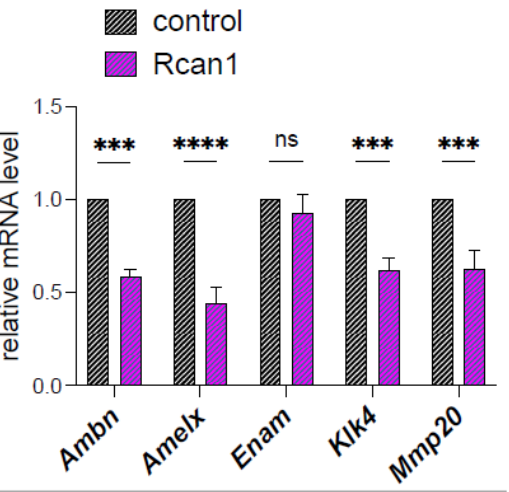
Figure 5. Relative mRNA expression by qRT-PCR of enamel genes in control and RCAN1 overex- pressing LS8 cells. Data represent the mean ± SEM of three independent experiments analyzed by Student’s t -test. *** p < 0.001, **** p < 0.0001.